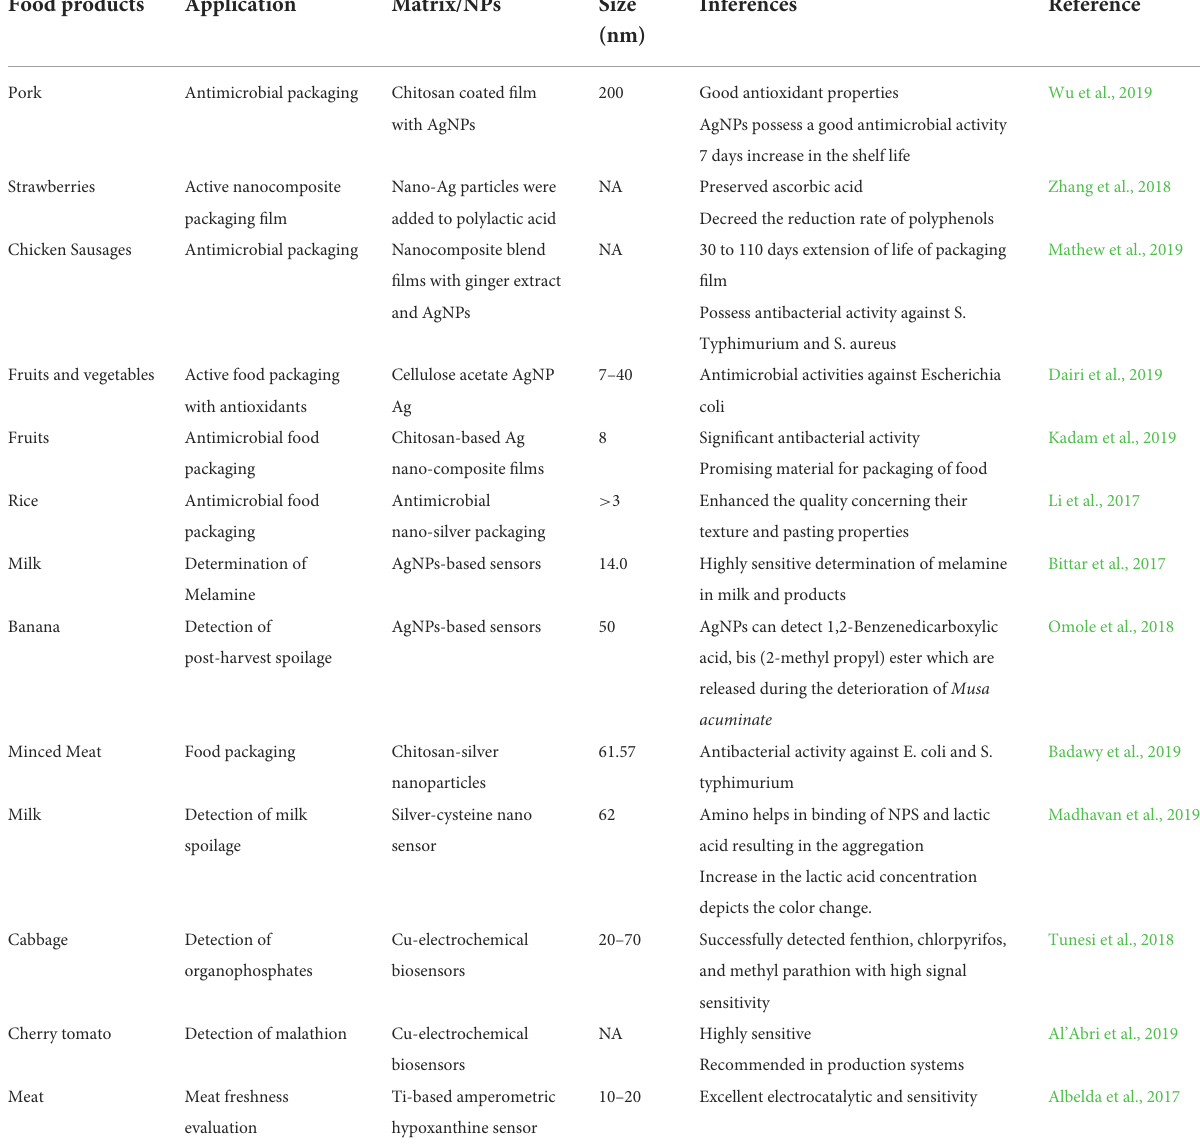
TABLE 2 Potential applications of metallic nanoparticles in shelf-life extension of foods. Food